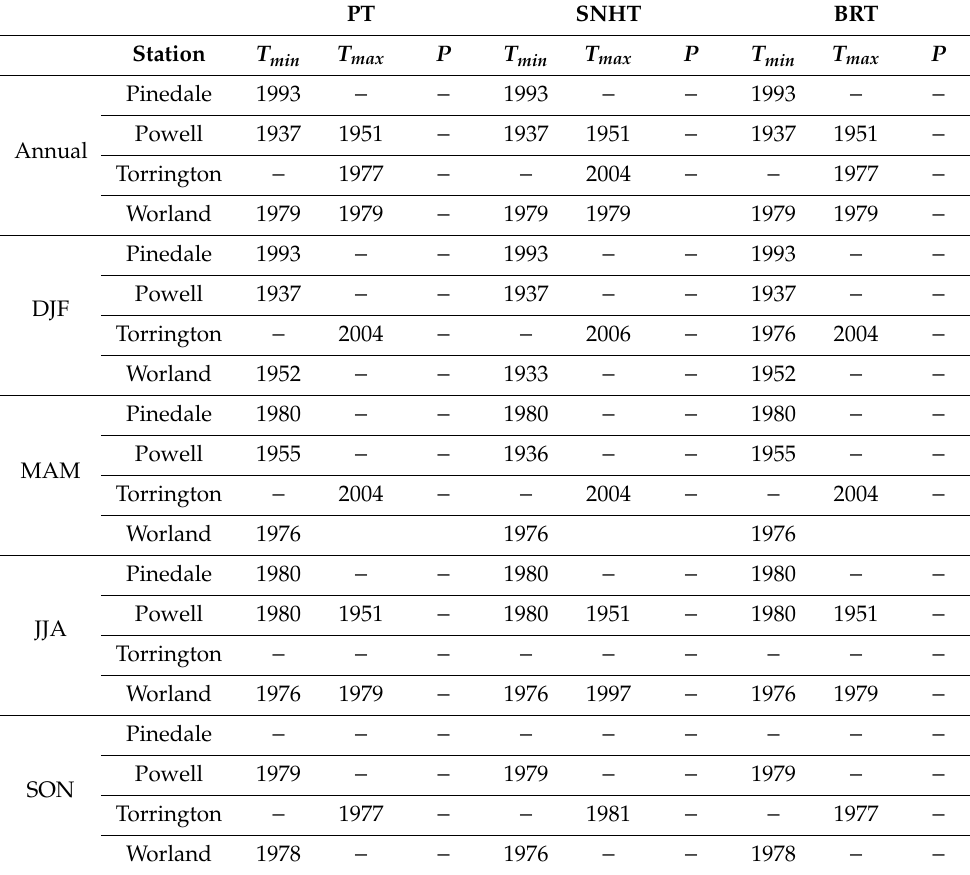
Table 5. Significant Trend Change Points (TCP, years) identified by Pettitt’s Test (PT), Alexandersson’s Standard Normal Homogeneity Test (SNHT), and Buishand’s Range Test (BRT) at Pinedale, Powell, Torrington, and Worland on an annual and seasonal time